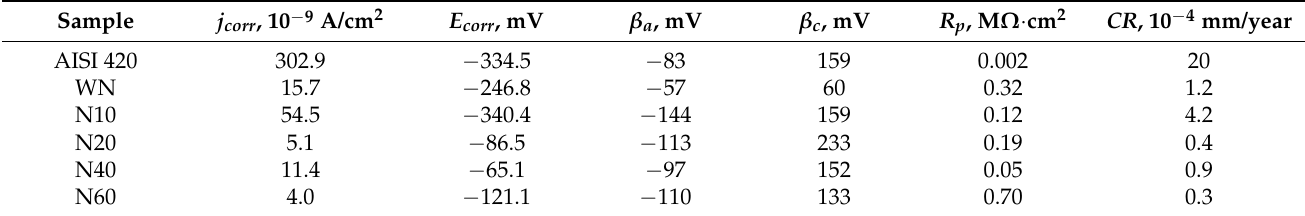
Table 2. Corrosion parameters of